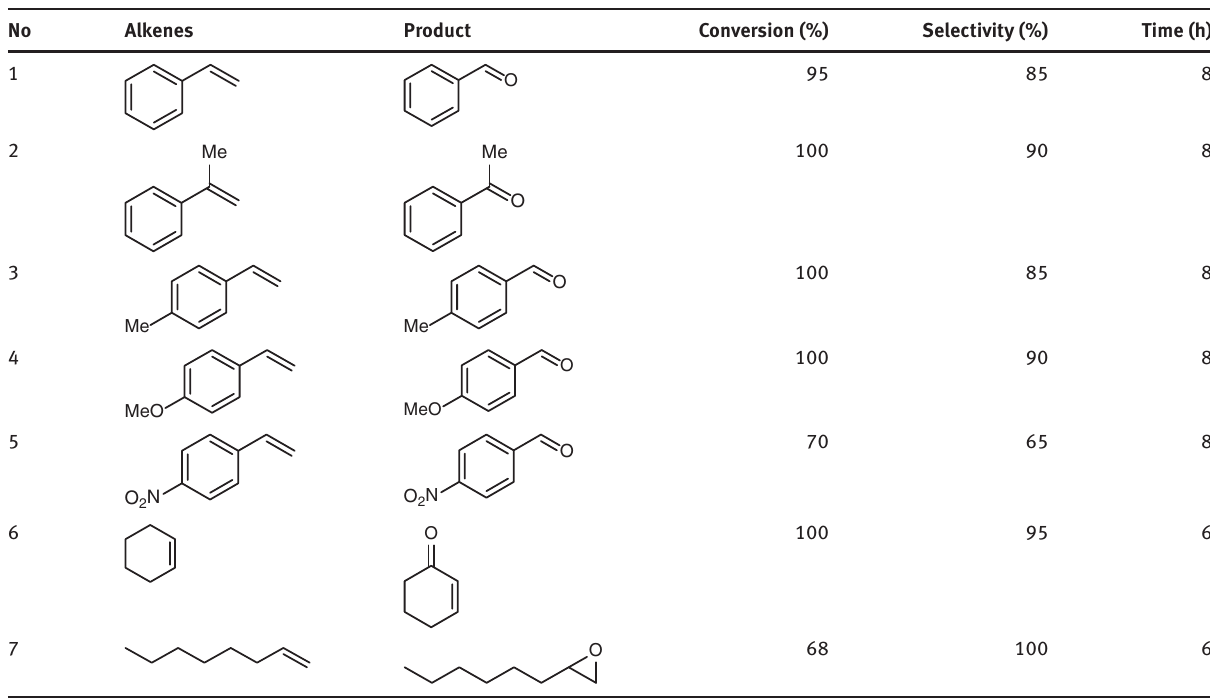
Table 4: Oxidation of some alkenes by t -BuOOH catalyzed by CF-MNPs 7